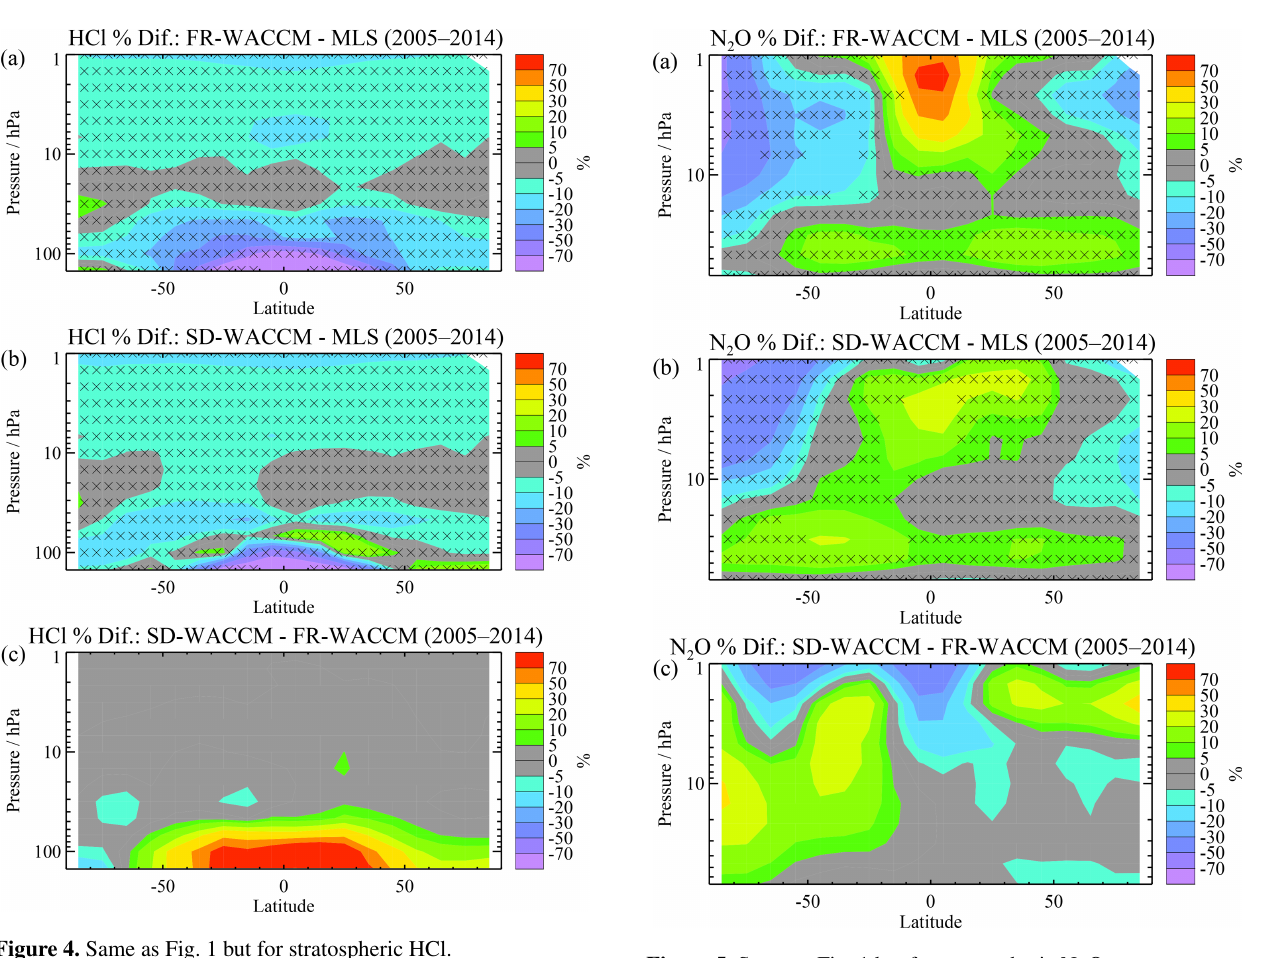
Figure 5. Same as Fig. 1 but for stratospheric N 2